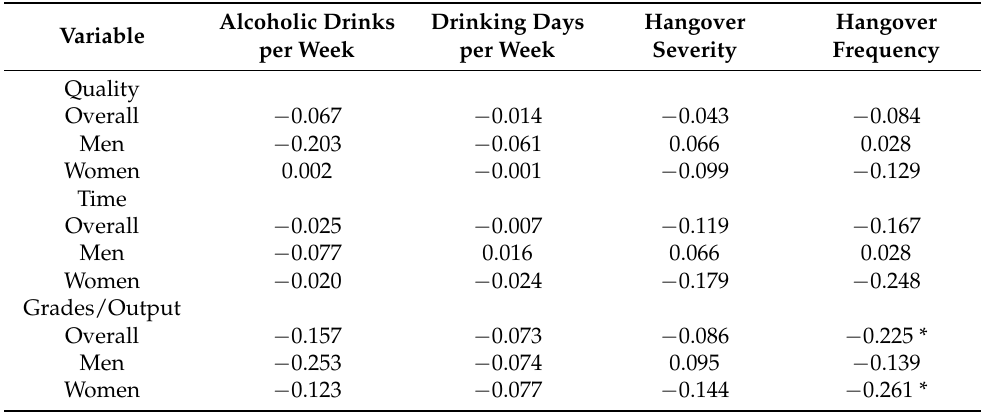
Table 4. Relationship between alcohol consumption and academic